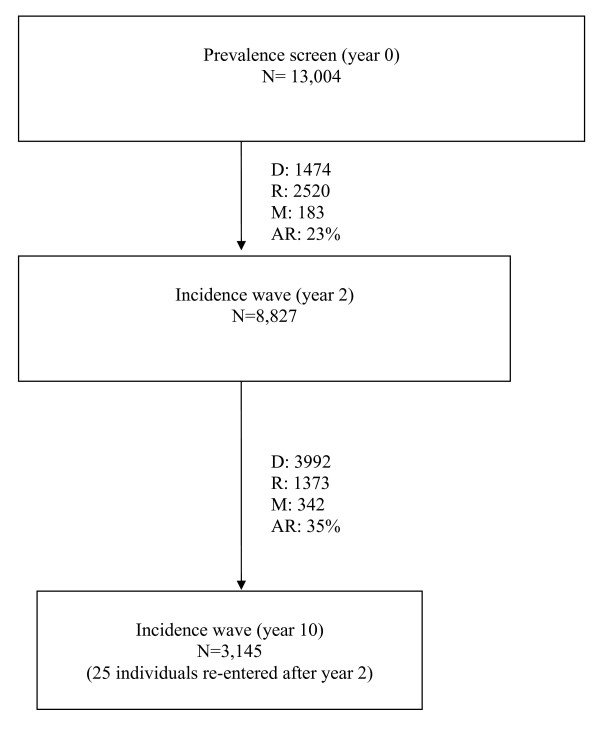
MRC CFAS major wave information. Key: N number interviewed; D – died between interviews; R – refused to be interviewed; M – moved between interviews; AR – attrition rate i.e. (R + M)/(R + M + N)